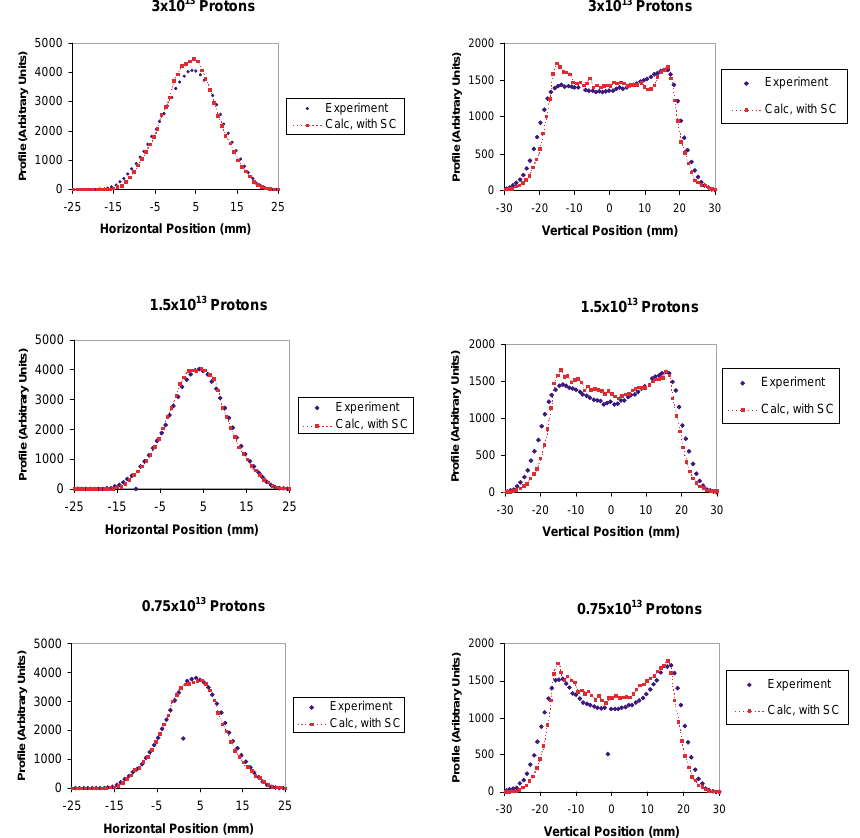
FIG. 4. (Color) Comparison of the calculated and measured horizontal and vertical distributions for three accumulated beam intensities, with no vertical painting. Space charge forces are included in the calculations.